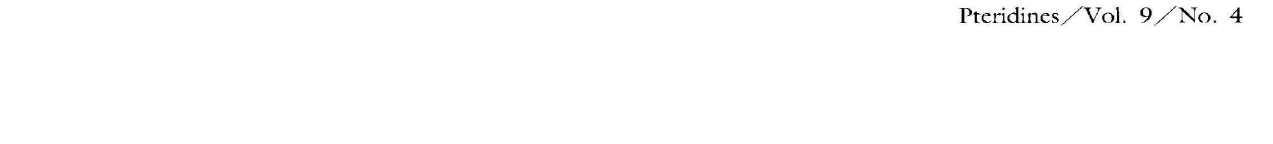
Picture 2. 80-year-old female patient with a bone defect of the medial part of the tibial plateau due to advanced osteoarthrosis of the knee (a); substitution of the tibial bone defect by autologous bone and implantation of a knee endoprosthesis